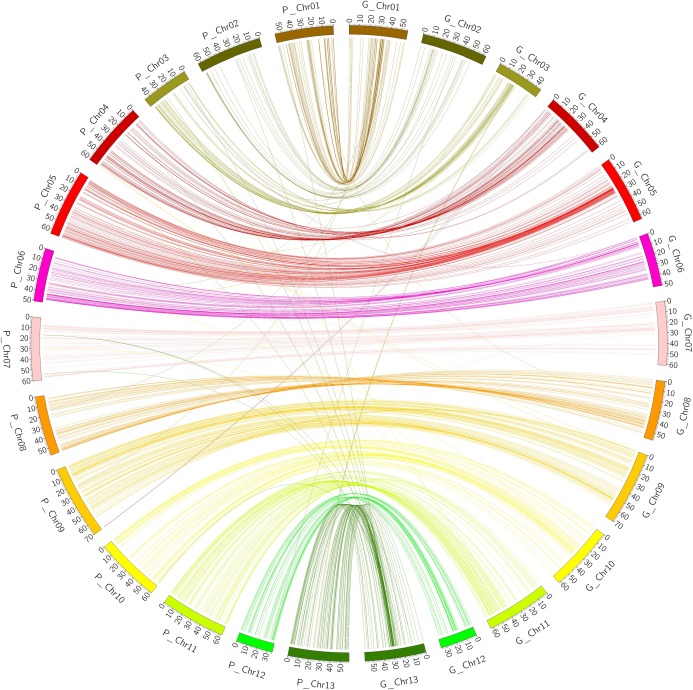
Collinearity between genetic and physical map of D5.The different colors represent the various syntenic block regions in the chromosomes.